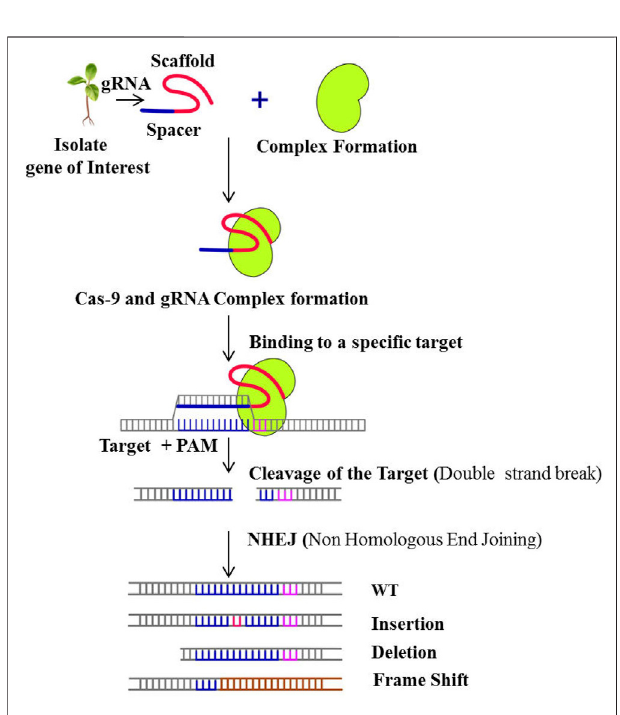
FIGURE 2 | Schematic presentation of mechanism of CRISPR/Cas-9 gene editing